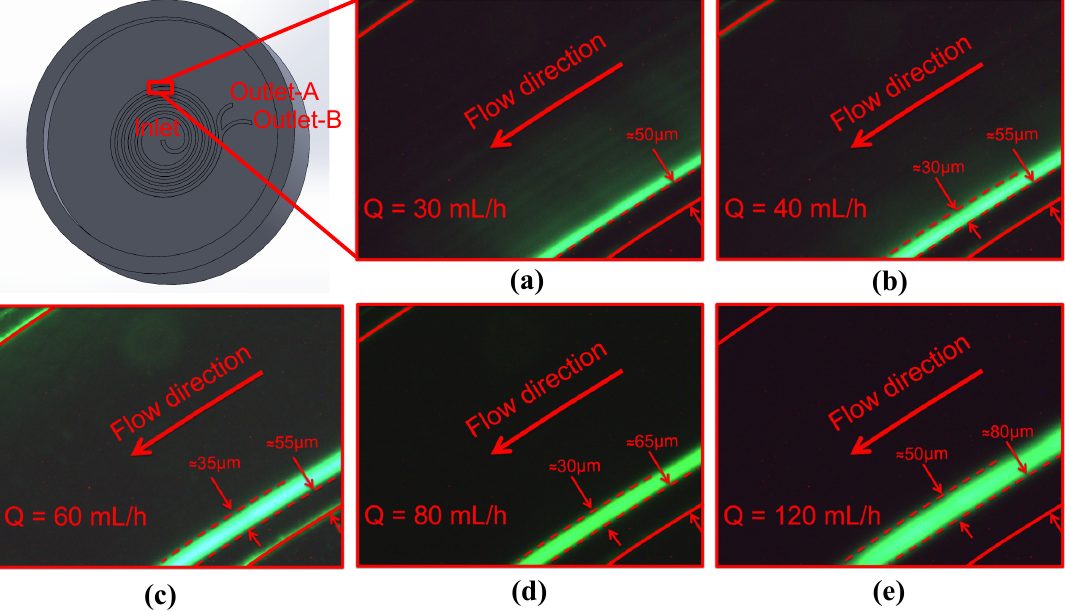
Figure 10. Experimental results for different flow rates (spiral channel with an AR 9.0, 10 µ m particles). Flow rate: ( a ) 30 mL/h; ( b ) 40 mL/h; ( c ) 60 mL/h; ( d ) 80 mL/h; ( 2 ) 120